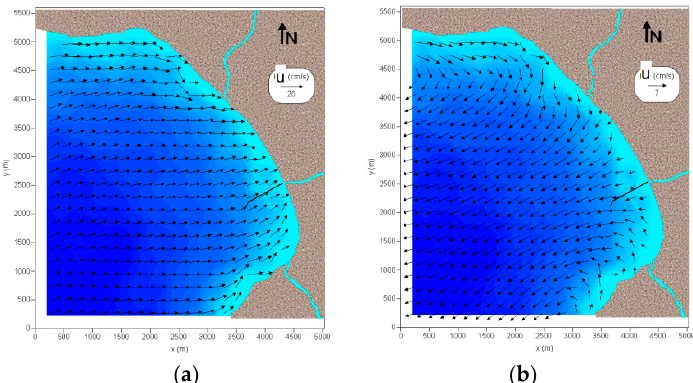
Figure 8. Current pattern: ( a ) sea surface layer and ( b ) bottom layer, for wind blowing from WSW with speed 10 m/s at the steady state [33].